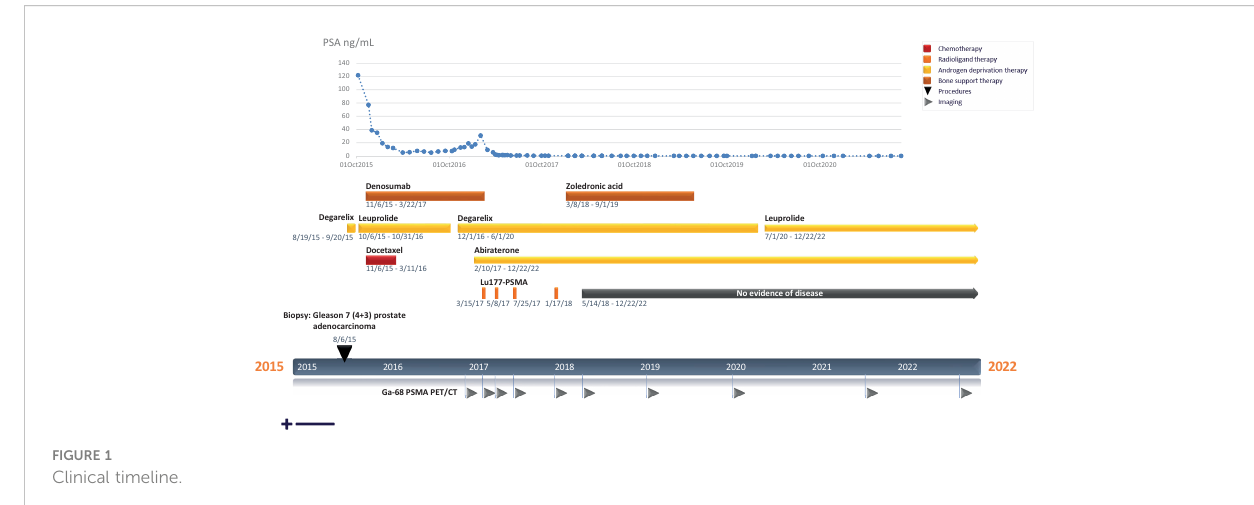
FIGURE 1 Clinical